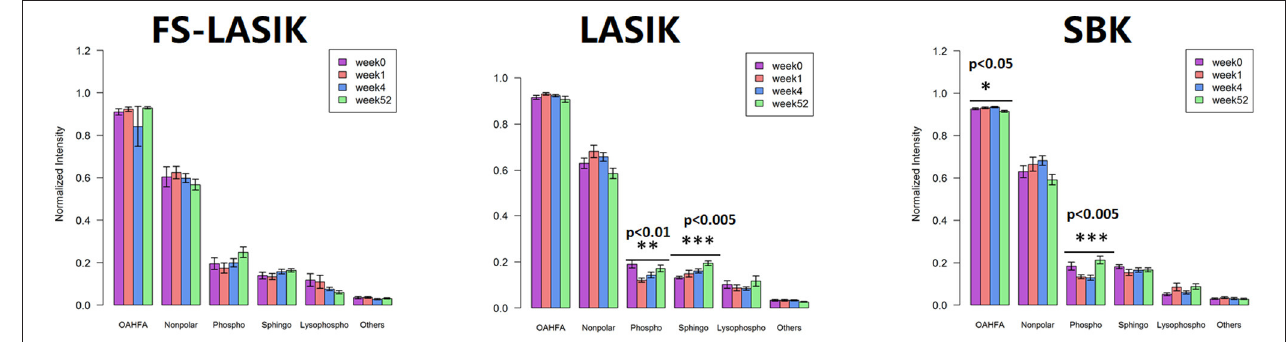
FIGURE 5 | Individual lipid classes found in the FS-LASIK, LASIK, and SBK groups at week 0, week 1, week 4, and week 52, respectively. (A–C) Non-polar lipid; (D–F) phospholipid; (G–I) lysophospholipid. * p < 0.05, ** p < 0.01, *** p < 0.005.